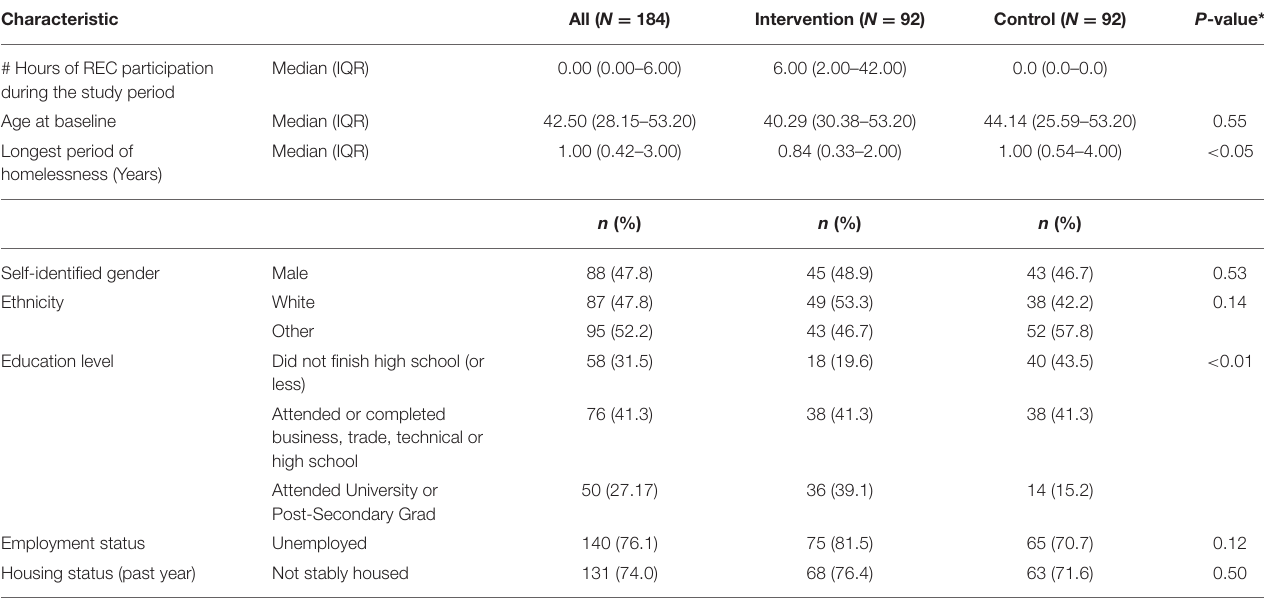
TABLE 2A | Sociodemographic characteristics for the intervention group and control groups at baseline.